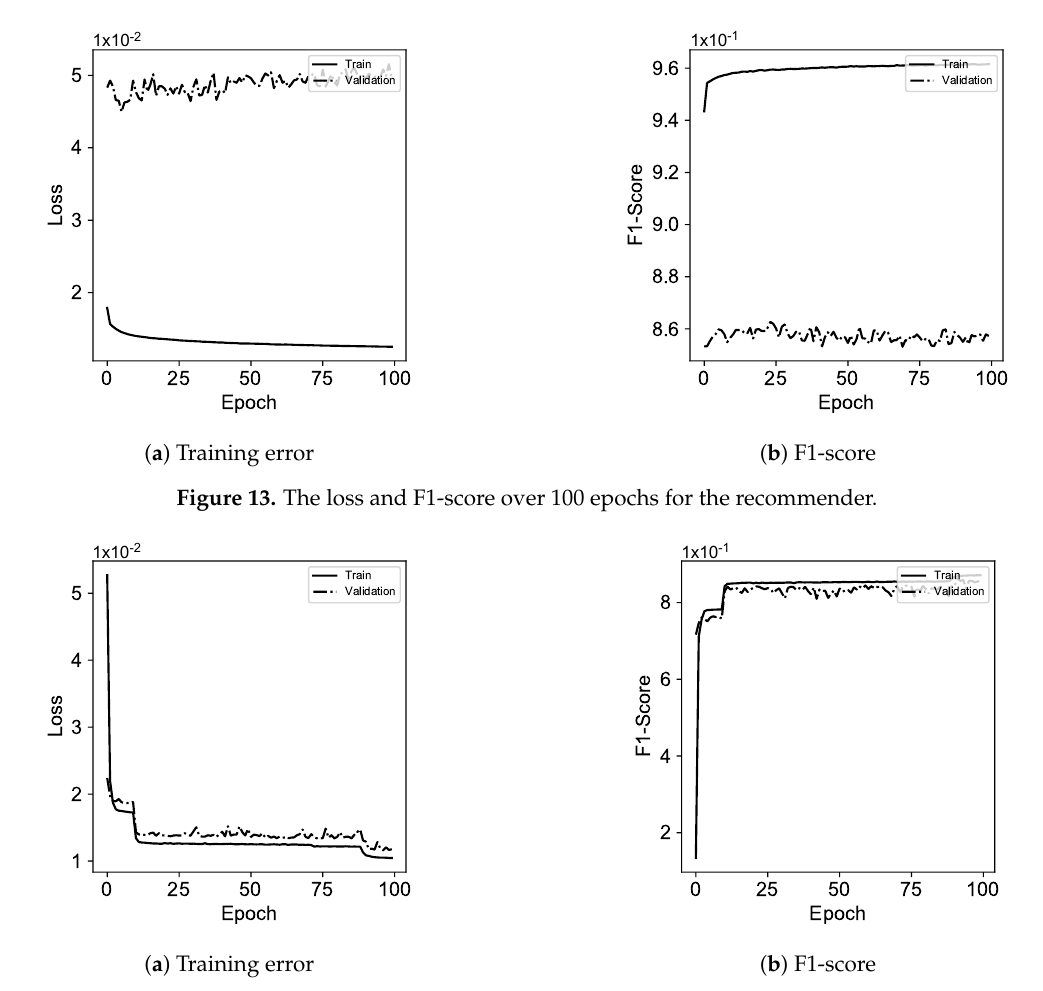
Figure 14. The loss and F1-score over 100 epochs for the runtime estimation